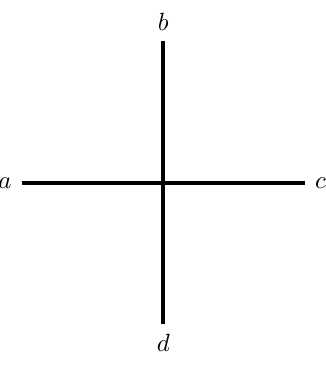
Figure 19. Tetrahedron channel (cid:24) N 9 2